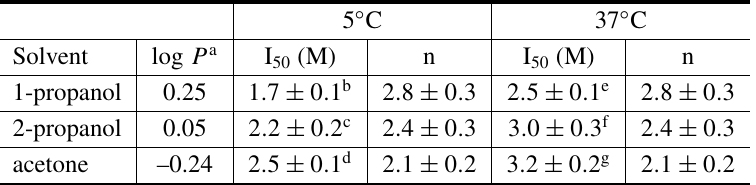
I 50 for inactivation of yeast inorganic pyrophosphtase by organic